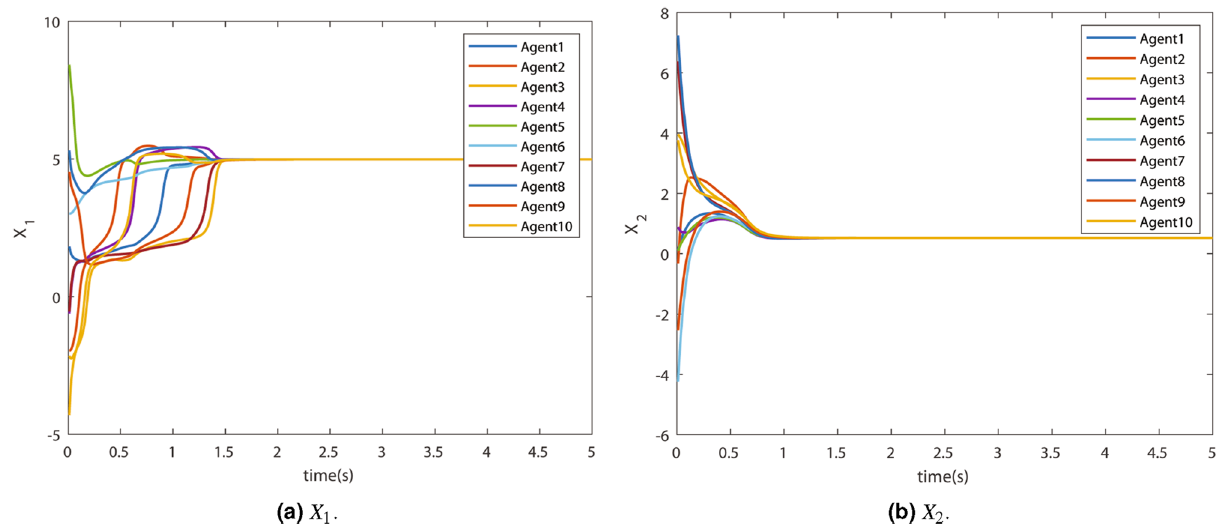
Figure 5. Actual state trajectories.